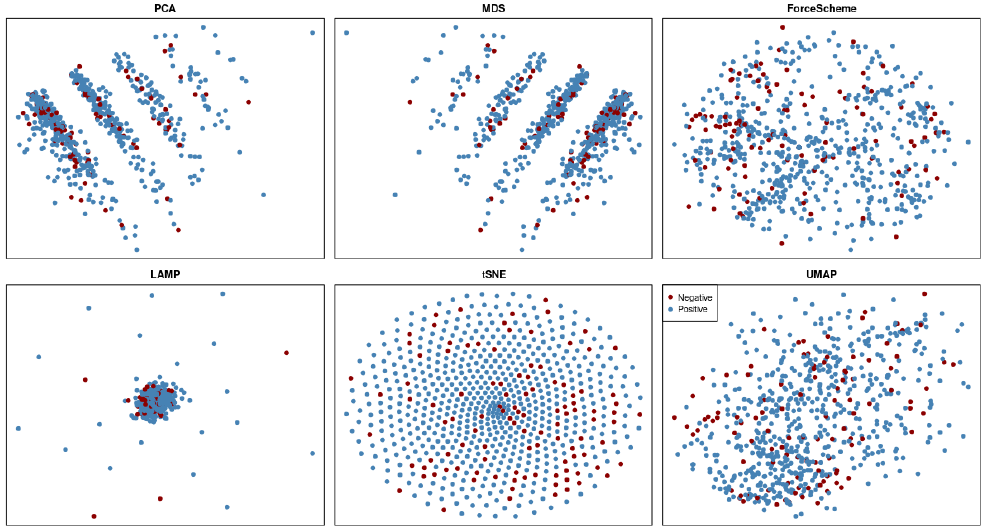
Figure 6. Projections of the user reviews, colored by the recommended labels (negative or positive). Source: elaborated by the